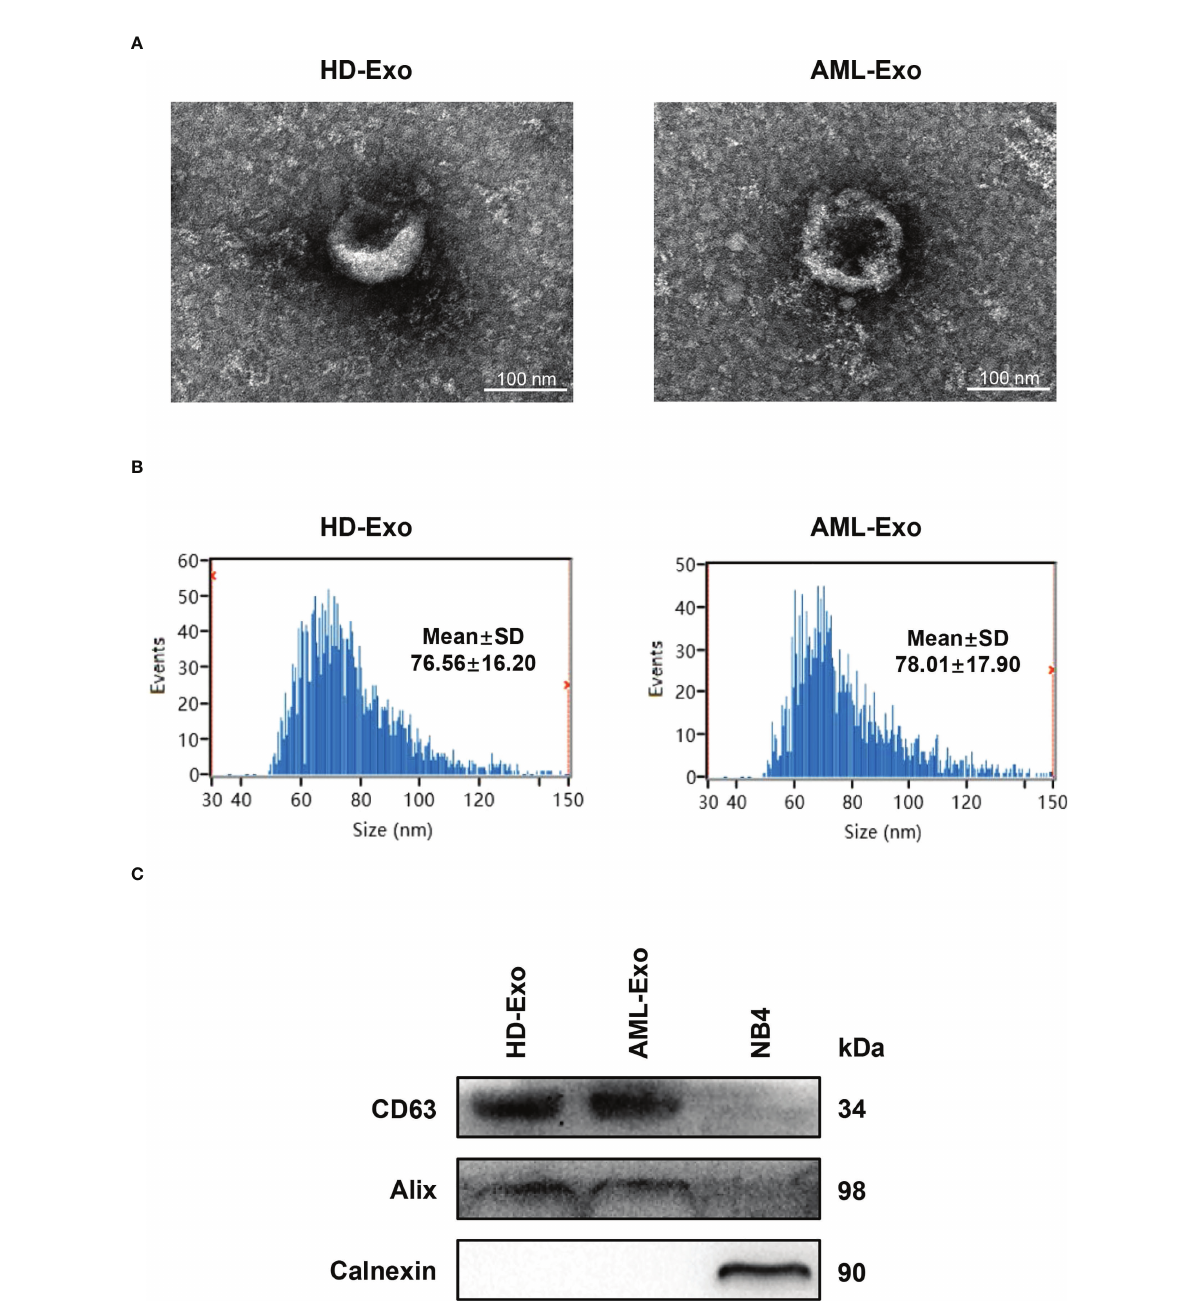
FIGURE 1 Characterization of Exosomes in Plasma. (A) Visualization of the morphologies of plasma exosomes isolated from the healthy donor (HD-Exo) and the newly diagnosed AML patient (AML-Exo) by transmission electron microscopy (TEM). (B) Measurement of the size distribution of HD- Exo and AML-Exo by nanoparticle tracking analysis (NTA). SD, standard deviation. (C) Western blot analysis of the level of exosome markers (CD63 and Alix) and a non-exosome marker (Calnexin) in HD-Exo, AML-Exo, and NB4 cell